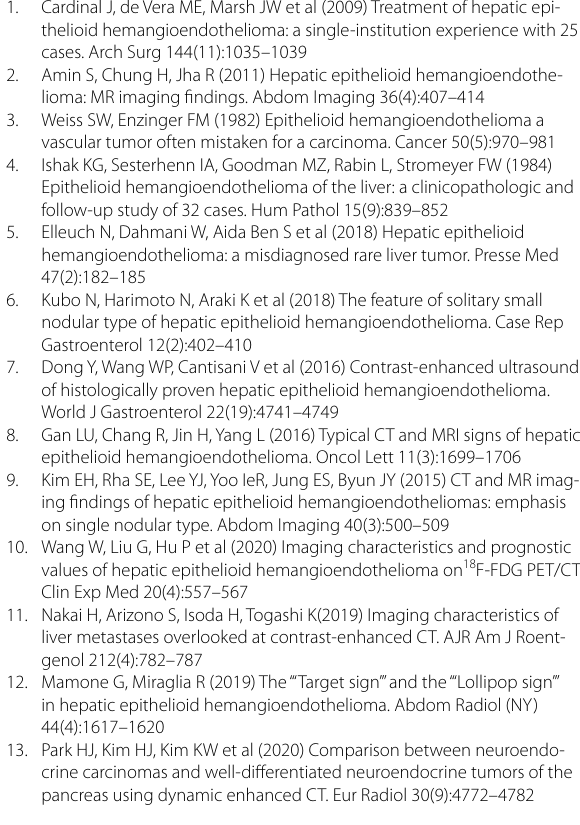
Table 5 Sensitivity and specificity of CT finding in diagnosis of HEH